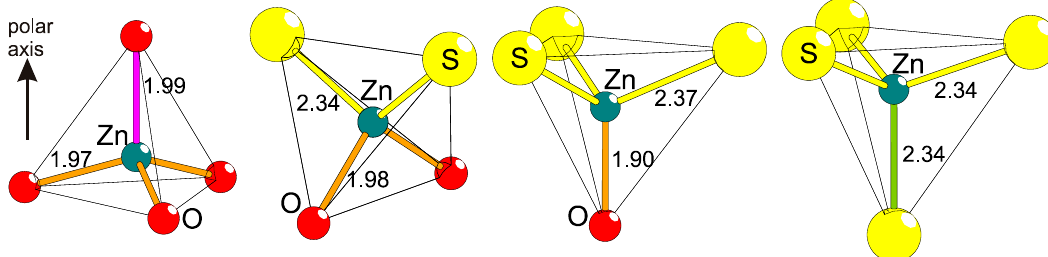
Figure 3. The principle of polar tetrahedral coordination is exhibited, as induced on Zn by S and O through heteroleptic coordination with comparisons to homoleptic ones. Displayed are, from left to right, the known examples ZnO [31], BaZnSO [6], CaZnSO [32], and 2H-ZnS [33]. The interatomic distances are differently colored to emphasize their different lengths (in Å).